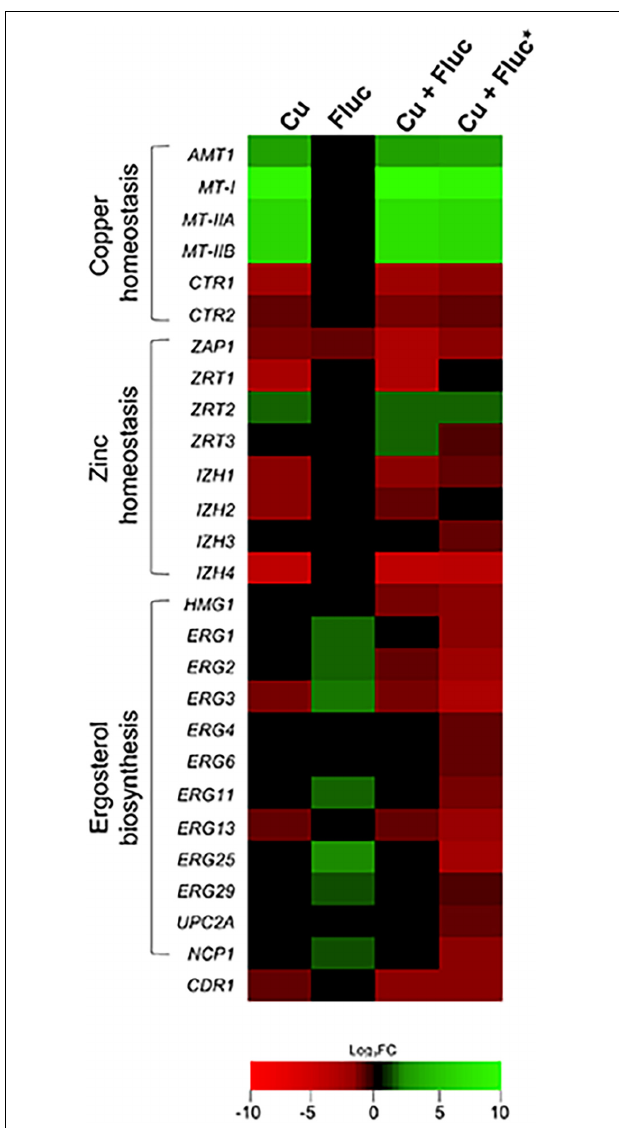
FIGURE 4 | Heatmap depicting Candida glabrata genes belonging to the subcategories ergosterol biosynthesis, copper and zinc homeostasis, which were differentially expressed under Cu, Fluc, or Cu + Fluc conditions. For each condition, the log 2 fold change (FC) of the selected transcripts is indicated using a color code (see the color bar). Genes significantly up- (log 2 FC > 1) or downregulated (log 2 FC < –1) in response to Cu, Fluc, or Cu + Fluc (treated versus untreated conditions) are shaded in green or red, respectively. Genes that were not differentially expressed between the treated and untreated conditions appear in black (–1 < log 2 FC < 1). The colors depicted in the Cu + Fluc* column indicate genes differentially expressed in Cu + Fluc conditions compared to Fluc conditions alone. S. cerevisiae gene names were used whenever the corresponding C. glabrata homolog name was not